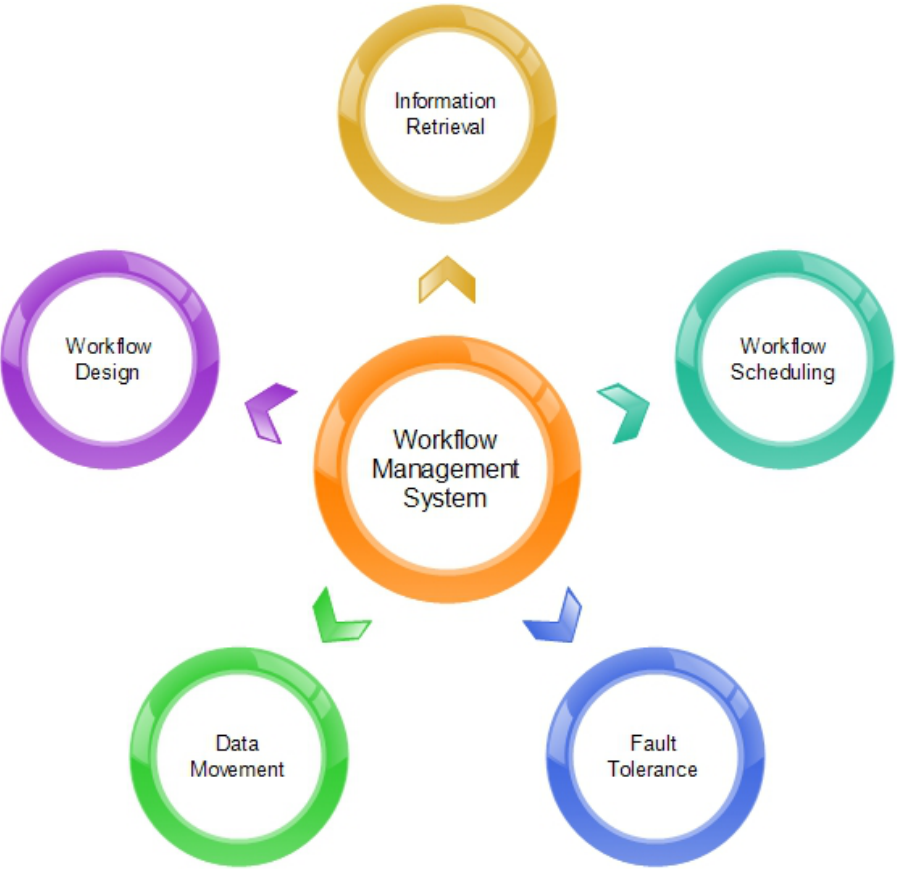
Figure 1. Elements of workflow management system